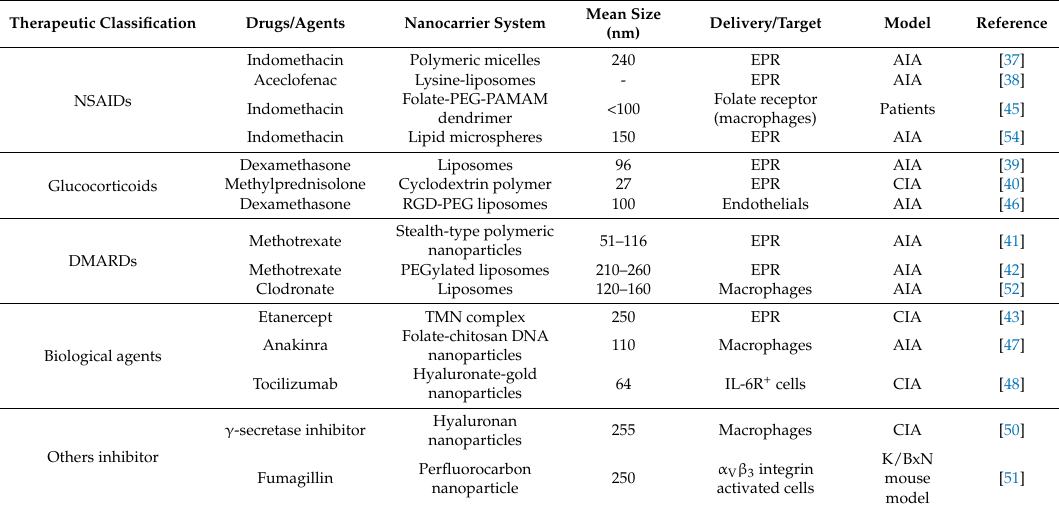
Table 2. Current nanocarrier system in the treatment of rheumatoid